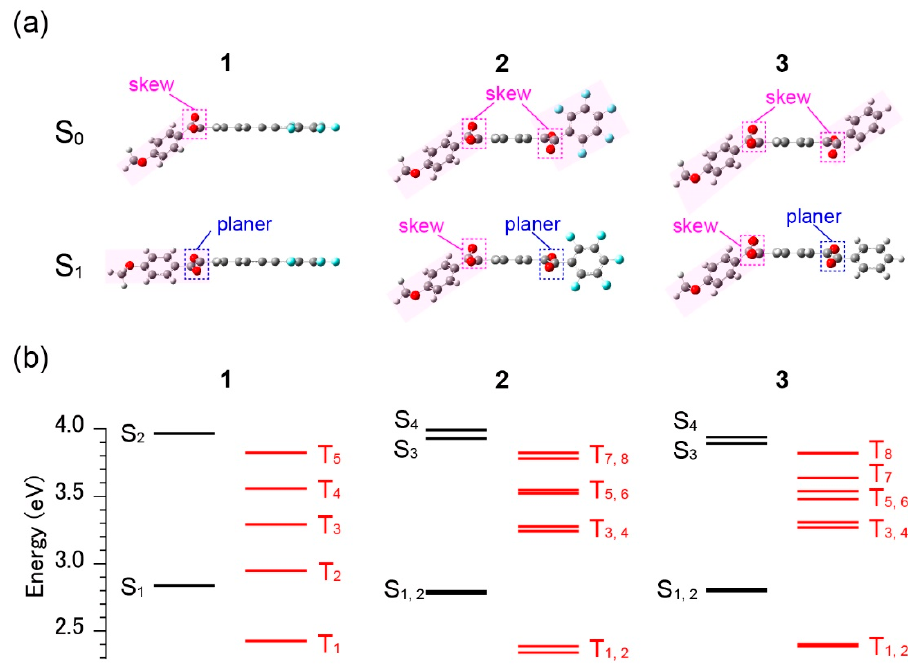
Figure 7. Theoretical calculations for 1–3 . ( a ) Optimised conformations at the S 0 , and S 1 levels. ( b ) Energy level diagram of some excited S n and T n levels. All calculations were conducted at the M06-2X / 6-31Gd level of theory. The calculated excitation energy, wavelength and oscillator strength are summarized in Table S2.